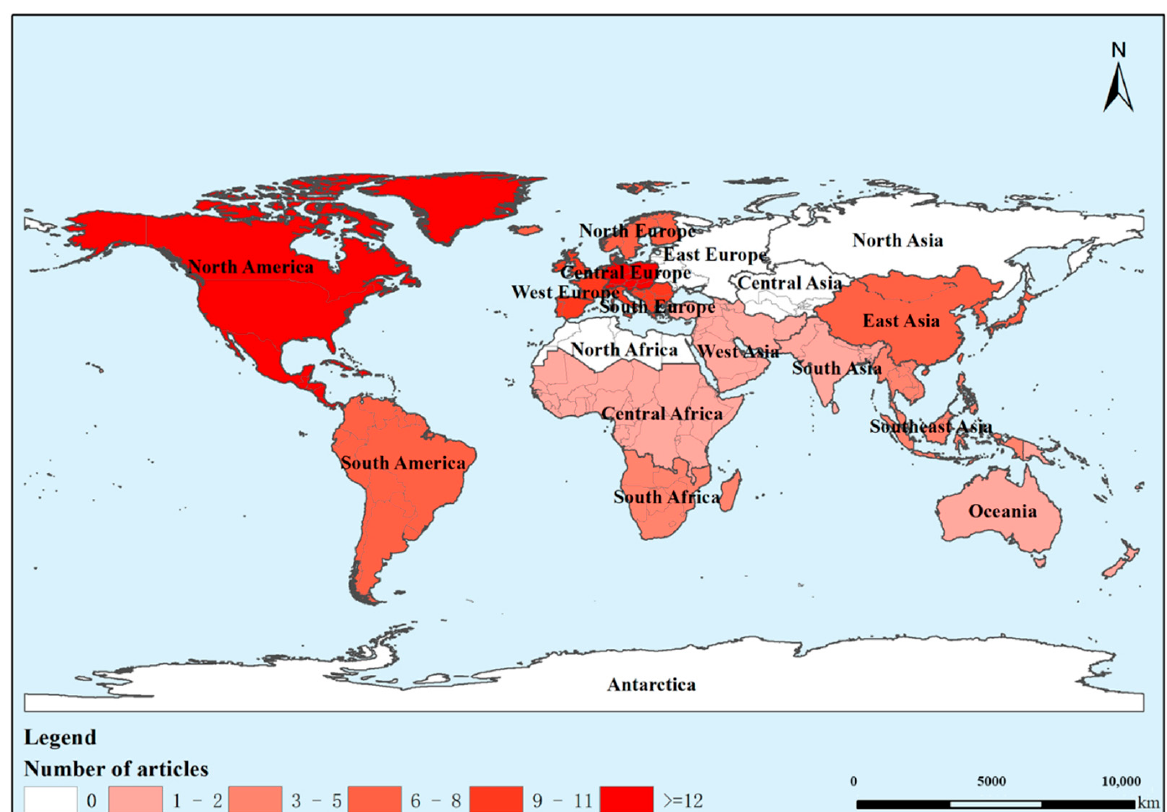
Figure 8. Regional distribution of case studies in the selected articles. Approximately half of the research articles were on a regional scale (Figure 9). One- third of the articles focused on a city scale, while national- and state/province-scale articles accounted for about 8 and 5%, respectively.